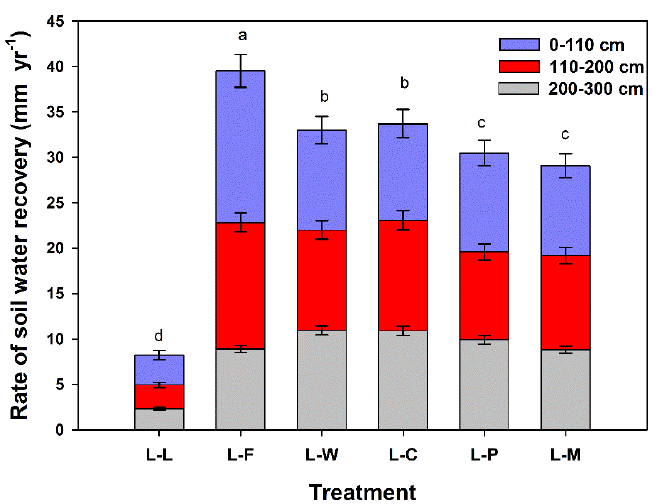
Figure 6. The saturation of available soil water in the 0–300 cm soil depth in October 2018. Different letters indicate treatment means that are significantly different ( p ≤ 0.05). Error bars indicate standard deviations of the means ( n = 3). Treatment abbreviations are defined in Table 1.